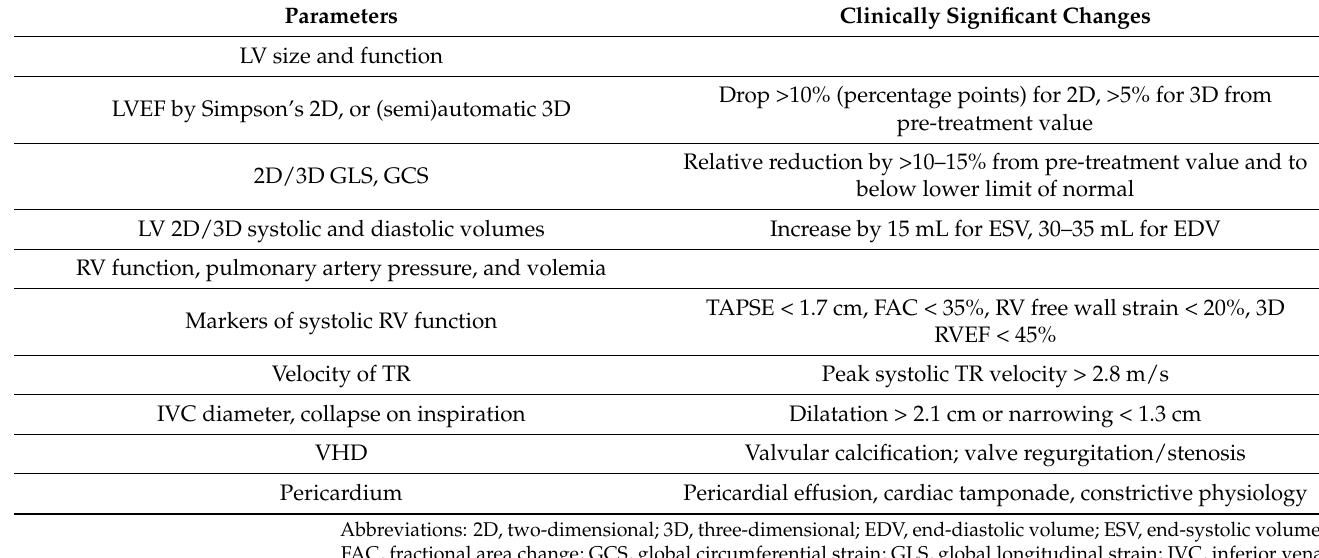
Figure 3. Echocardiography in the evaluation of chemotherapy CV side-effects. A 58-year-old female patient with known dyslipidemia and no other cardiovascular disease ( Panel A ). The patient was affected by stage IIIC high-grade serous ovarian cancer. She underwent four sessions of taxol/carboplatin protocol (S/P 4 cycles) before surgical debulking. After the last chemo session, she developed shortness of breath during mild physical effort which she never experienced before. At TTE, a significant reduction in LVEF and GLS compared with the baseline was seen ( Panel B ). The patient was put on metoprolol and Lisinopril. Atorvastatin and TTE were repeated after 1 month with evidence of mild improvement in LVEF and GLS ( Panel C ). Abbreviations: EF, left ventricular ejection function; GLS, global longitudinal strain; TEE, transthoracic echocardiography. In addition, it provides accurate information regarding heart structure, function, and derived Doppler intracardiac hemodynamics (Table 3). Table 3. Echocardiography protocol for cardio-oncology surveillance [33,38,61].